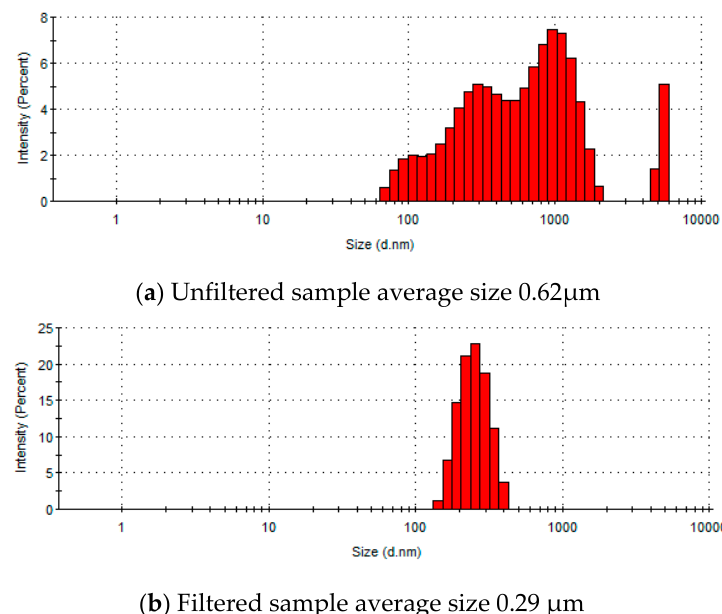
Figure 2. Particle size distribution in raw wastewater samples ( a ) and after filtration through 0.45 µ m filter ( b ).